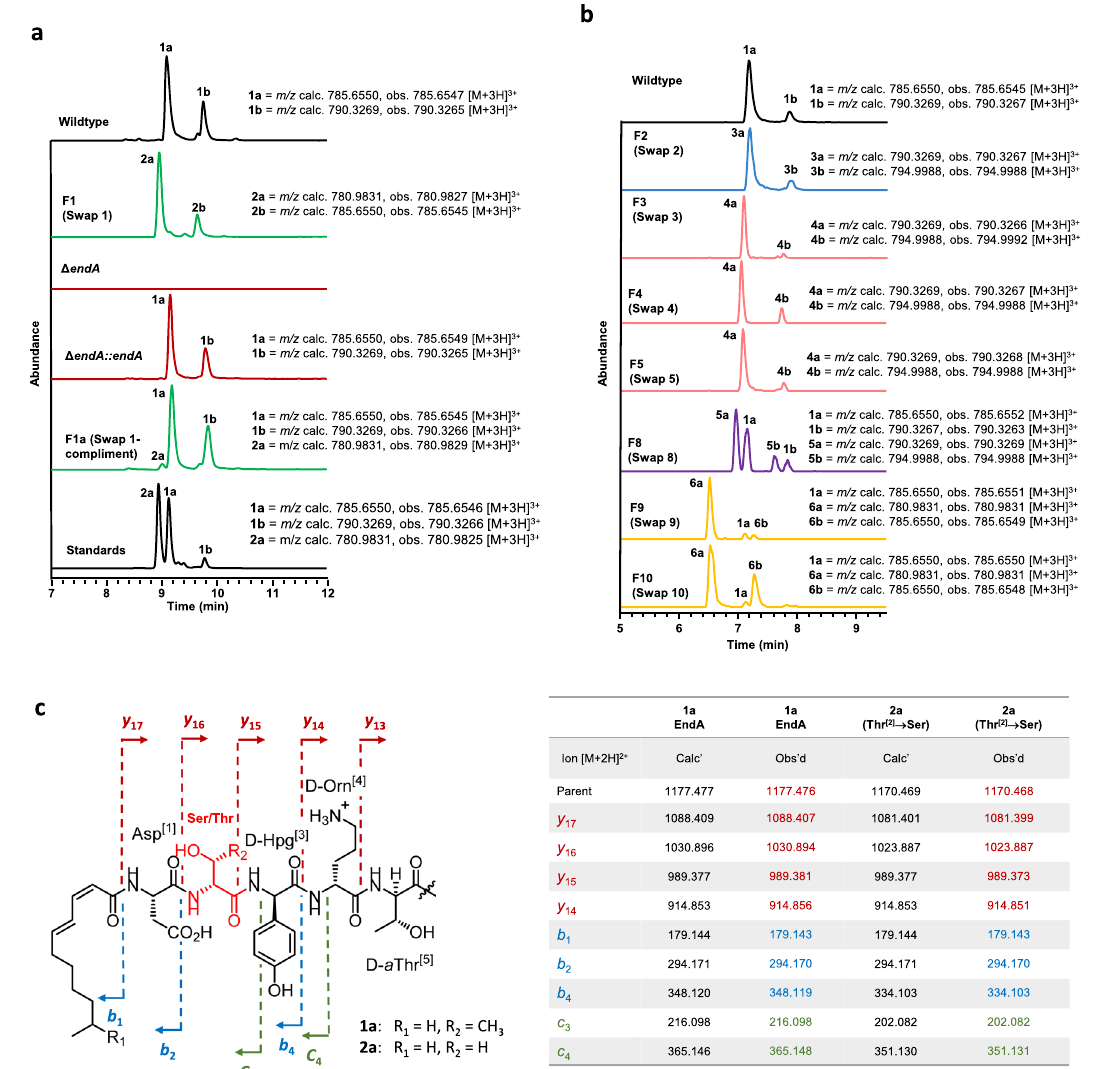
Fig. 3 Combined extracted ion chromatographs (EIC) of enduracidin a and b analogues from LC-HRMS analysis of extracts from primary S. fungicidicus strains (F1-10) used in this study (normalized to 100%), and tandem mass characterization of 2a. a LC-HRMS comparison between CRISPR-Cas9 editing and conventional gene complementation methods for introducing subdomain swaps. The F1a (Swap 1-complement) complementation strain produces mostly 1a & 1b , whereas the CRISPR-Cas9 edited strain S. fungicidicus F1 (Swap 1) produces Ser-containing enduracidins 2a & 2b . b LC-HRMS analysis of all productive mutants that generate new enduracidin analogues. c LC-HRMS/MS analysis of 1a and 2a con fi rms that Thr has been replaced with Ser in compound 2a . Fragment ions containing residue 2 are 14 mass units higher in 1a compared with 2a (methyl group of Thr). Loss of residue 2 results in fragment ions with identical m/z values between 1a and 2a